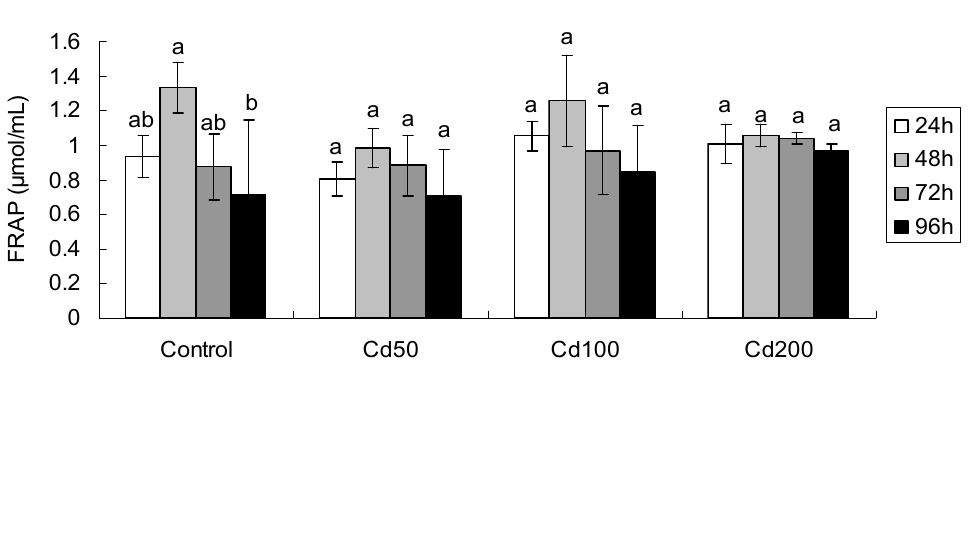
Figure 1. The total antioxidant capacity (FRAP) in germinating soybean seeds after different periods of exposure. All values are mean ± SD (n = 4). Values followed by lower case letters are significant at p <